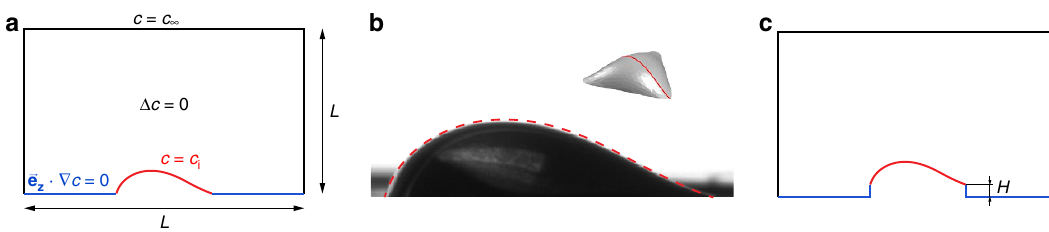
Figure 6 | 3D numerical problem. ( a ) Two-dimensional schematic. ( b ) Comparison of the experimental drop shape and the geometry calculated with Surface Evolver. ( c ) Problem investigating the effect of the pedestal height. Note that the schematics are not to scale and the simulations are in 3D.